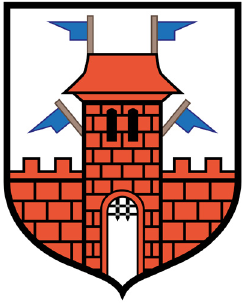
Figure 16. The arms of Czernina.